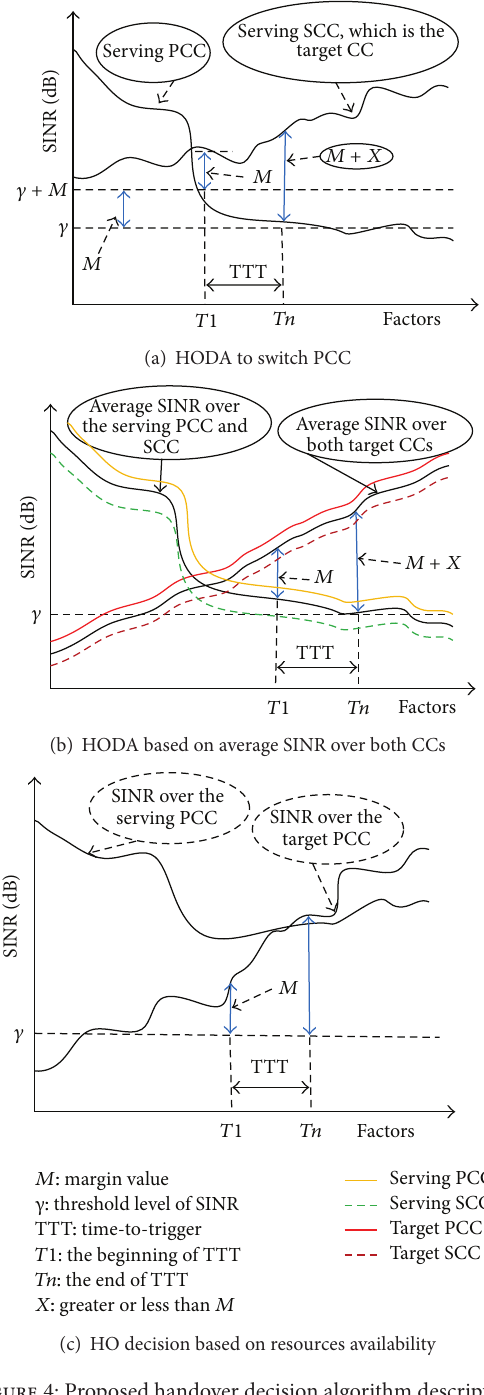
Figure 4: Proposed handover decision algorithm description.